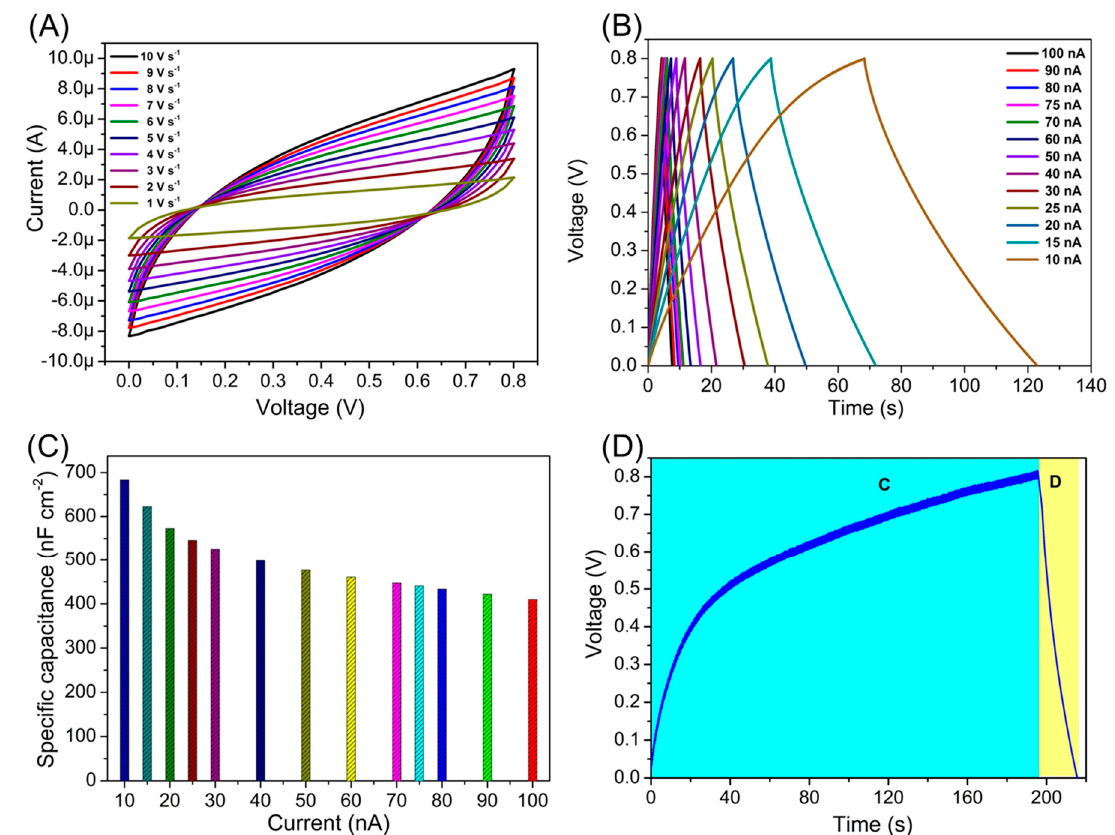
Figure 4. Electrochemical characterization of the PVDF/reduced graphene oxide symmetric supercapacitor (SSC). ( A ) Cyclic voltammetry profiles of PVDF/reduced graphene oxide SSC recorded using various scan rates (1–10 V s − 1 ). ( B ) Galvanostatic charge-discharge profiles of the PVDF/reduced graphene oxide SSC recorded using different current (10 to 100 nA). ( C ) Effect of current on the specific capacitance of the PVDF/reduced graphene oxide SSC. ( D ) The charging profile of the PVDF/reduced graphene oxide SSC with the applied compressive force of 40 N applied to the PVDF/sodium niobate nanogenerator device.